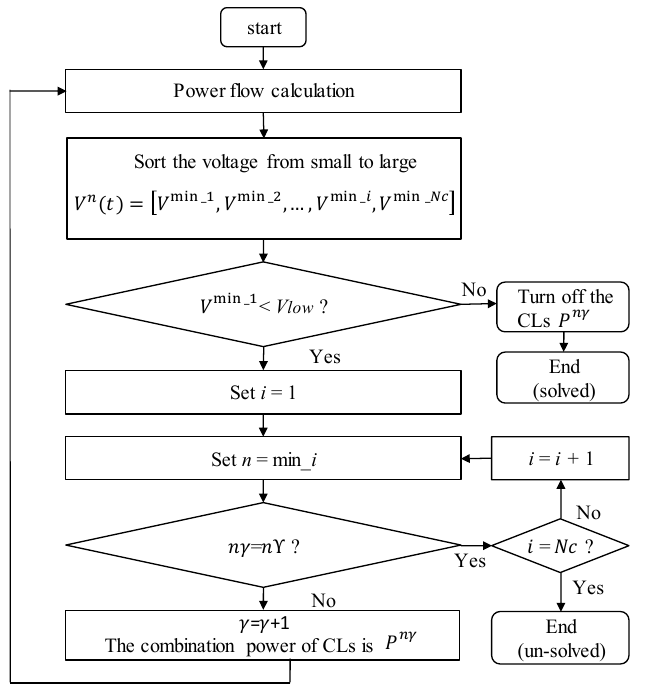
Figure 7. Flow chart of the VRSA: under-voltage regulation.